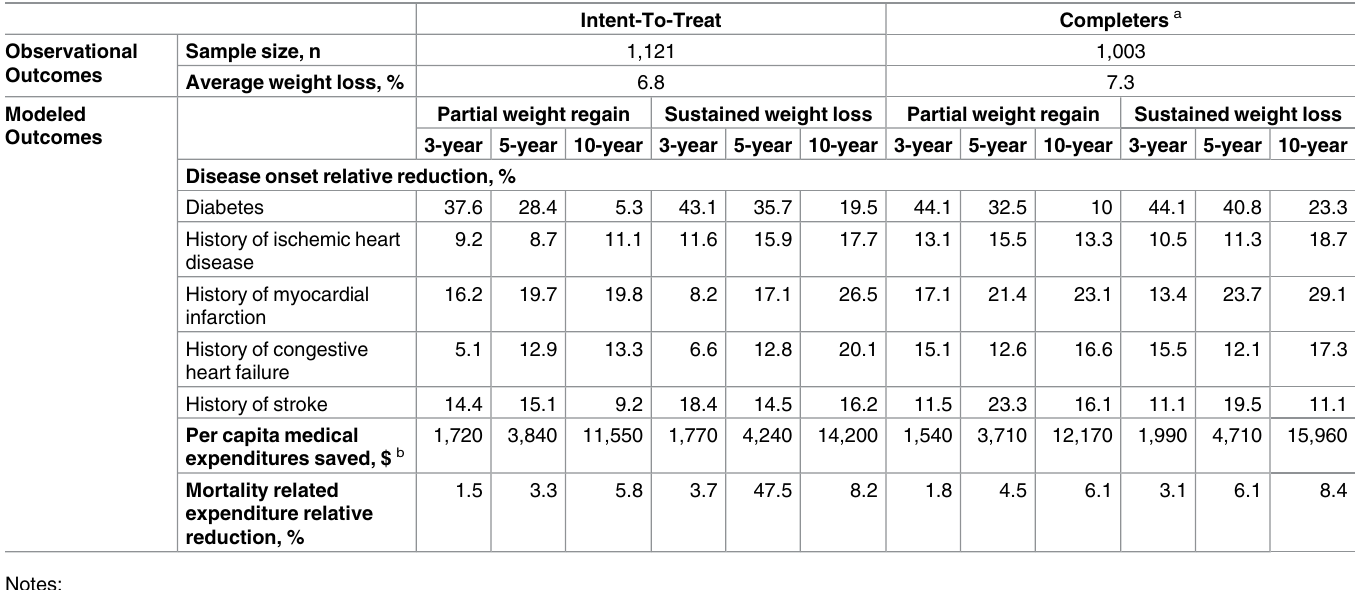
Table 3. Outcomes for Population with CVD Risk Factors and Subgroups.